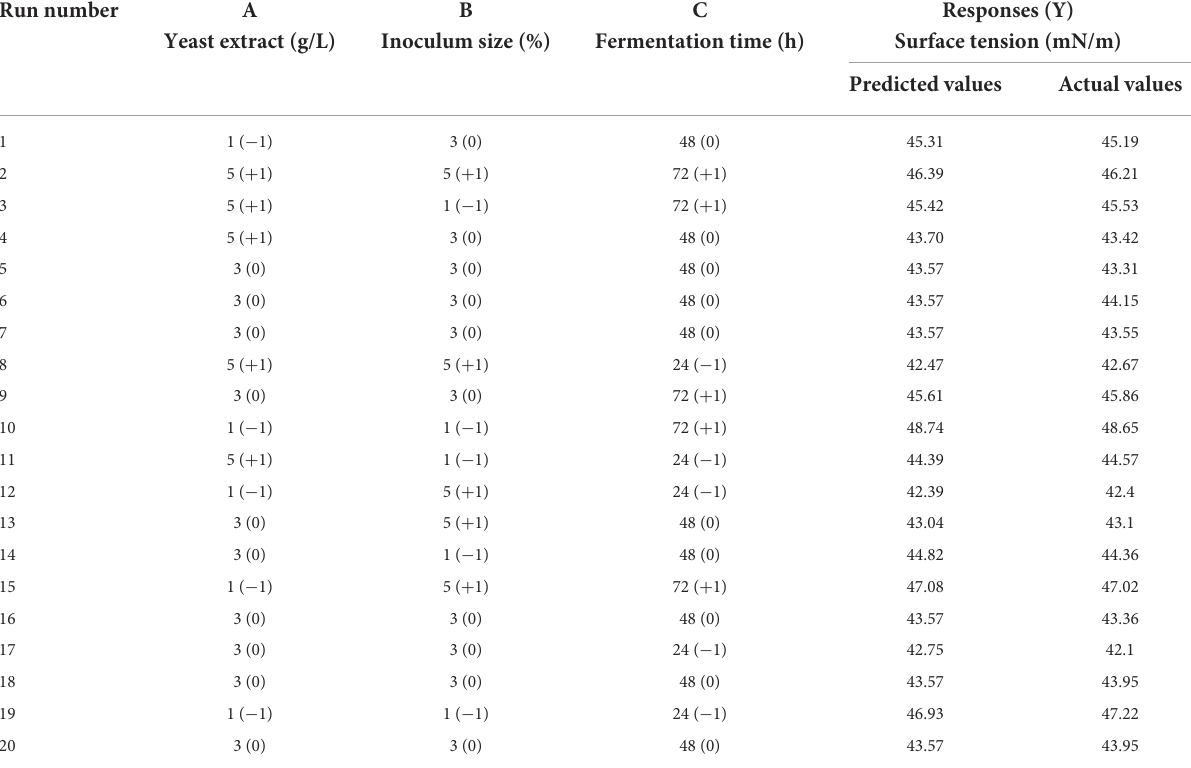
TABLE 3 Central composite design runs showing actual and predicted variables and the responses.